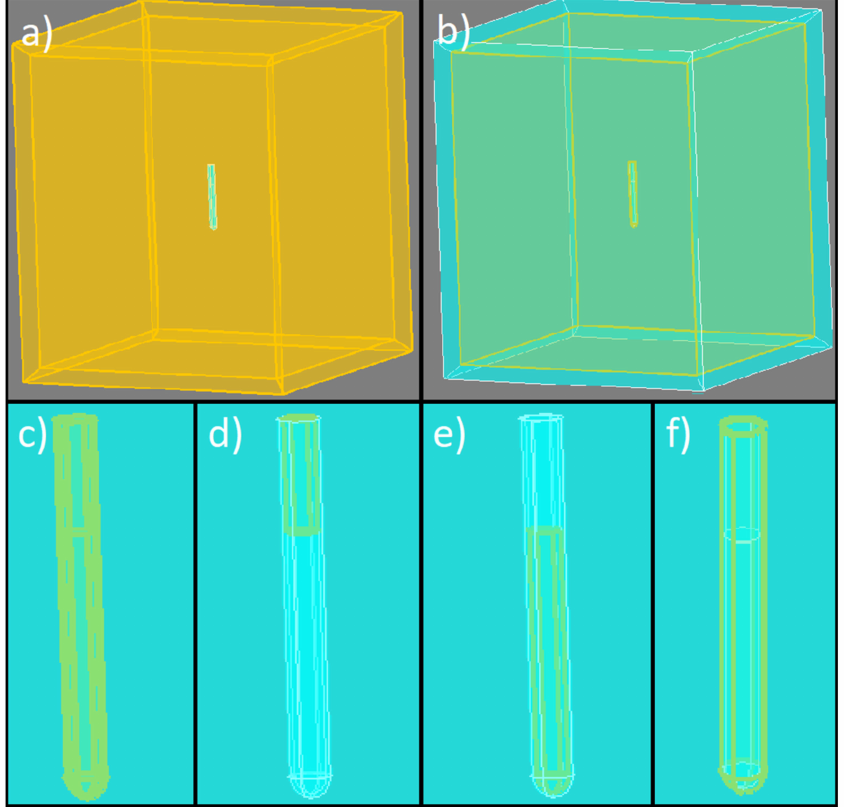
Figure 3. Regions in the model. Regions are marked with yellow and are as follows: ( a ) Infinite box region, ( b ) Non-active air region, ( c ) Glass container region, ( d ) Air region inside the container, ( e ) Magnetic fluid region, and ( f ) Face region around the container with defined radiation emissivity, absorption, and convection